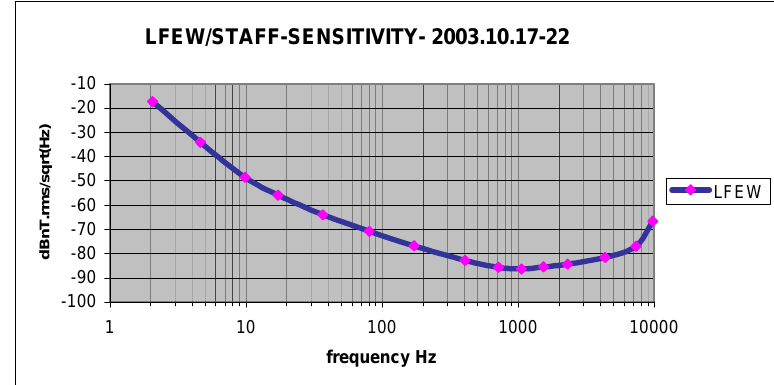
LFEW/STAFF-SENSITIVITY- 2003.10.17-22